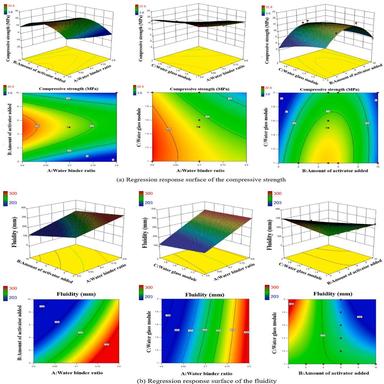
Regression response surface (a: Regression response surface of the compressive strength, b: Regression response surface of the fluidity).